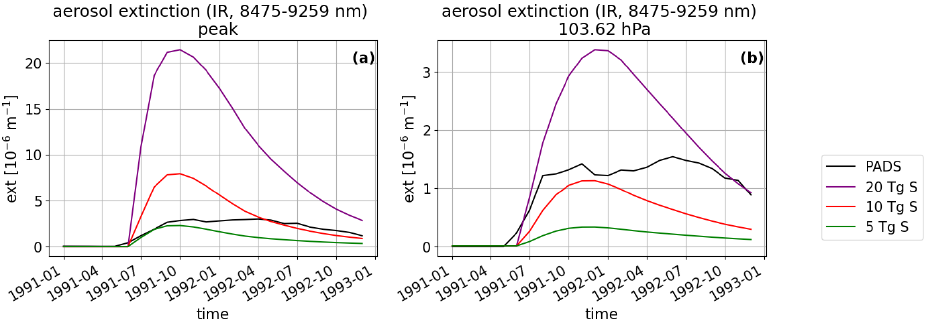
Figure 11. Temporal evolution of the aerosol extinction at the profile peak (a) and the cold-point region (b) for the 8475–9259nm IR